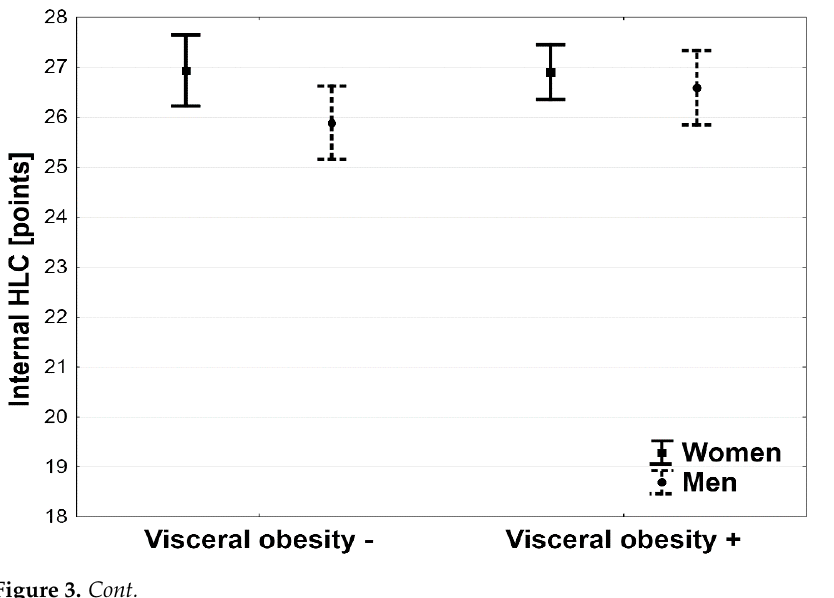
Figure 3. Health locus of control and sex and visceral obesity.